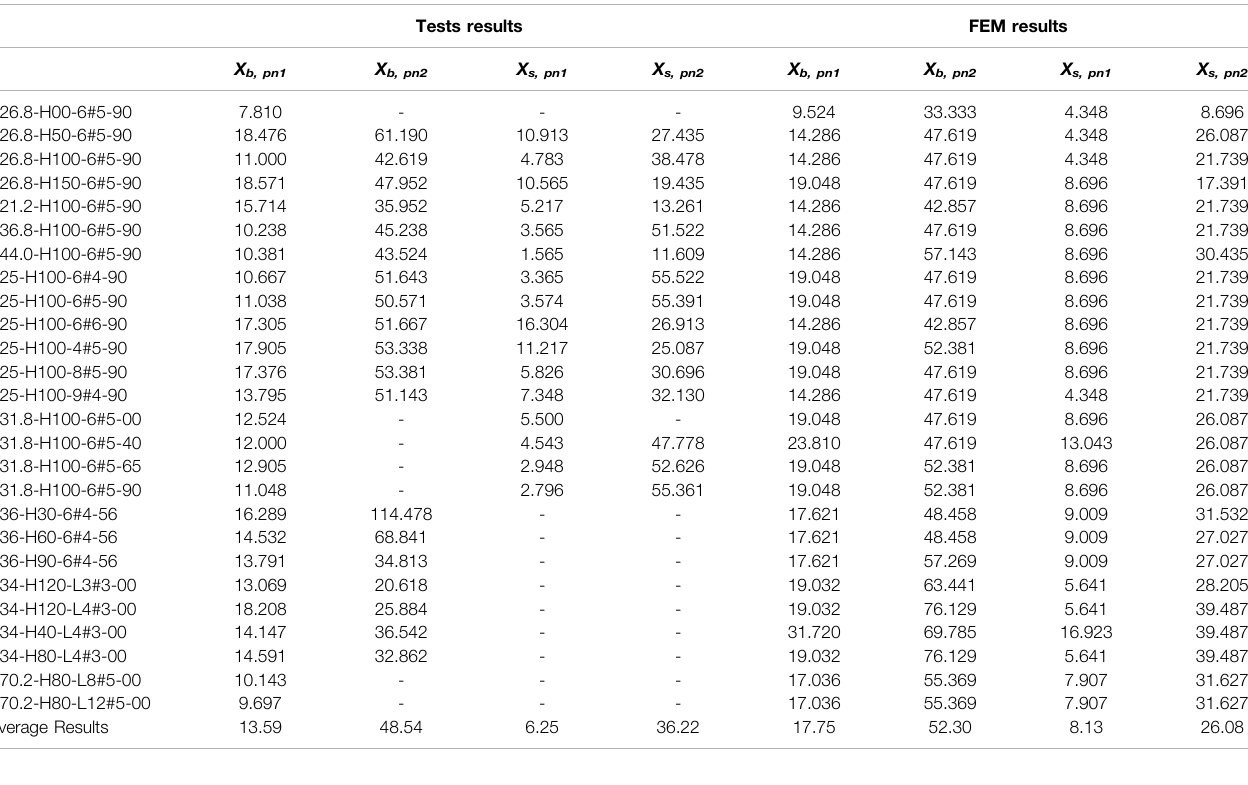
TABLE 3 | Experimental and FEM strain results of longitudinal and spiral reinforcement bars.